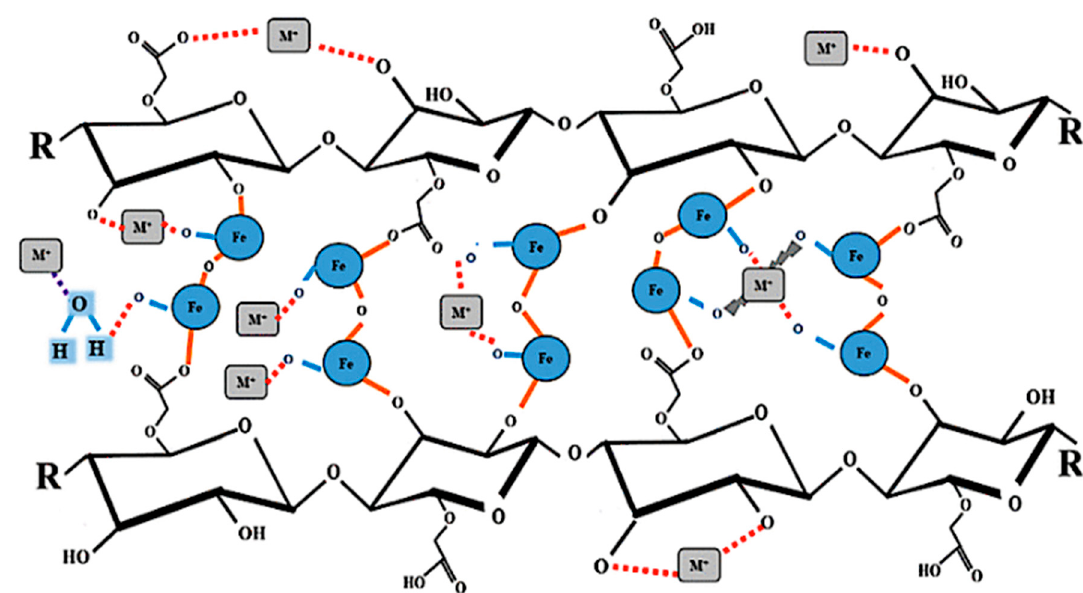
Figure 15. Scheme of adsorption mechanisms on